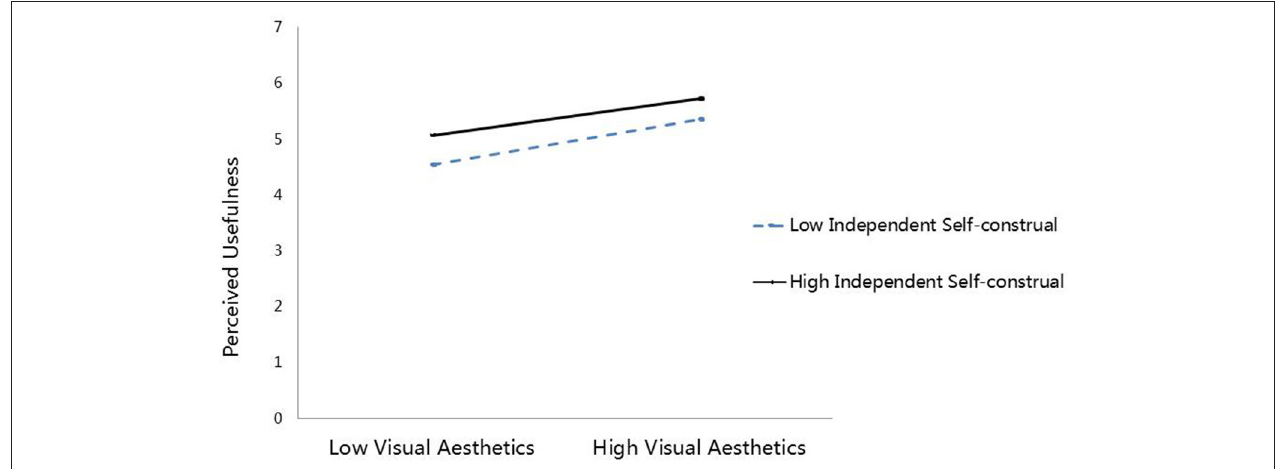
FIGURE 3 | The moderating effect of independent self-construal between visual aesthetics and perceived